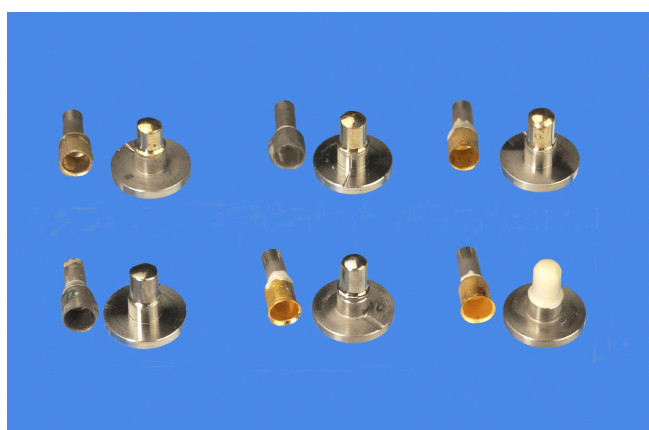
Figure 1. Schematic portrayal of the metal base part used in all cases (dimensions in mm); ( A ) part supporting the primary crown; ( B ) connection area to the material testing device.